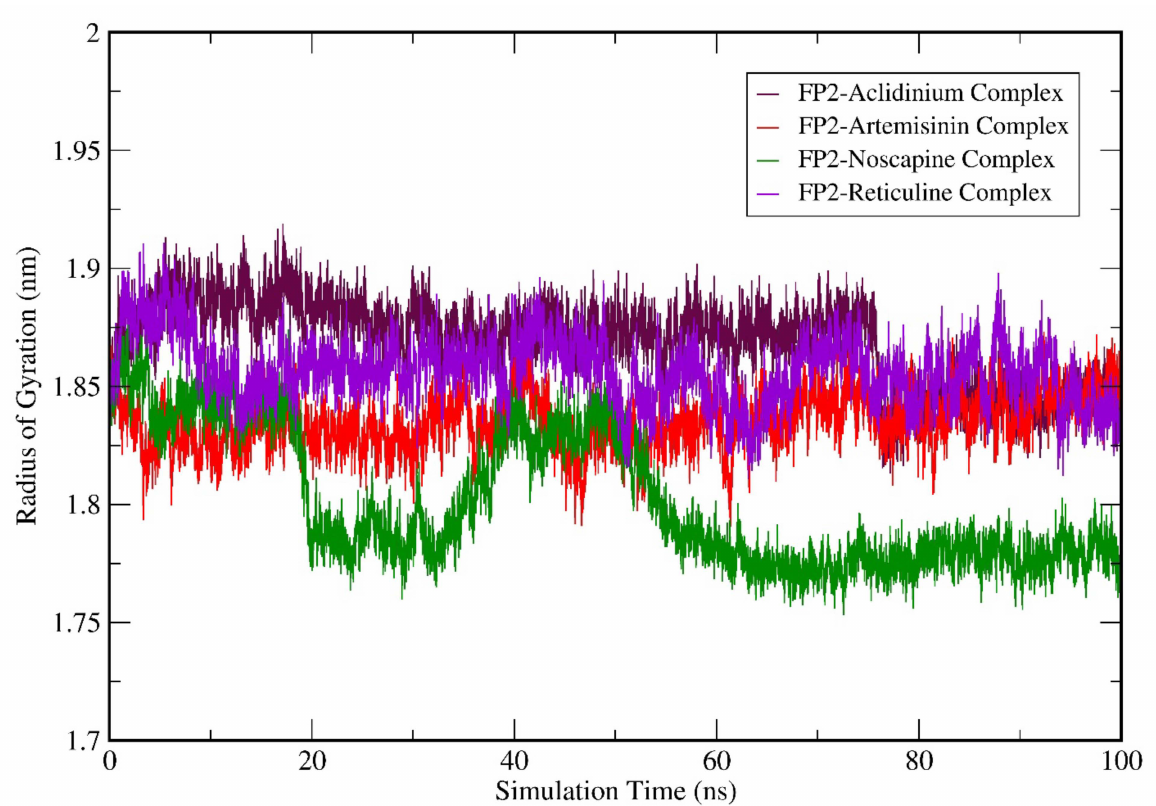
Figure 7. Molecular dynamics simulation (MDS) result analysis for FP-2-Artemisinin, FP-2 Noscapine, FP-2 Reticuline, and FP-2 Aclidinium complexes representing Rg (Radius of gyration).